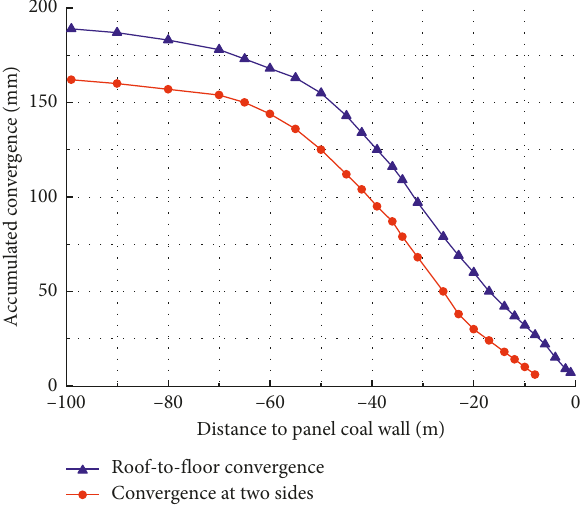
Figure 18: Displacement curve of the